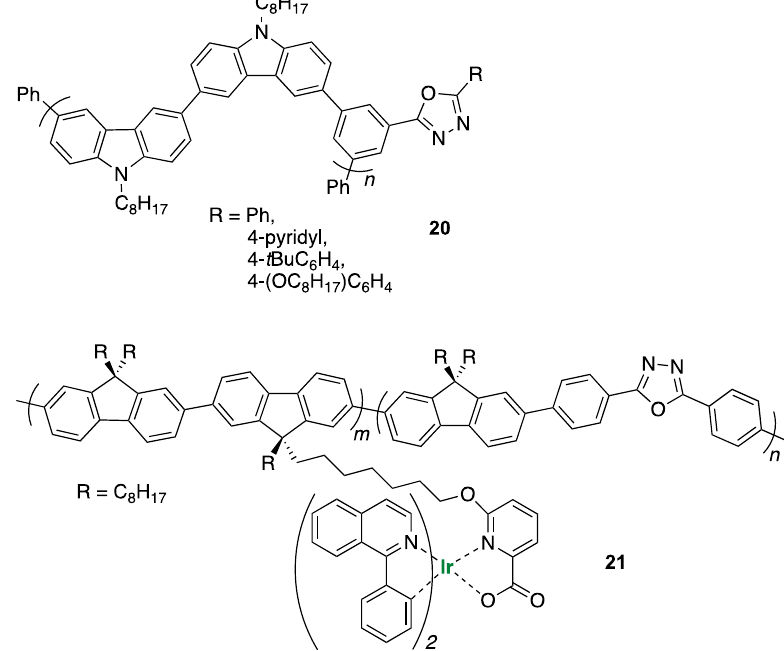
Figure 10. Structures of reported polymeric structures bearing 1,3,4-oxadiazole units.